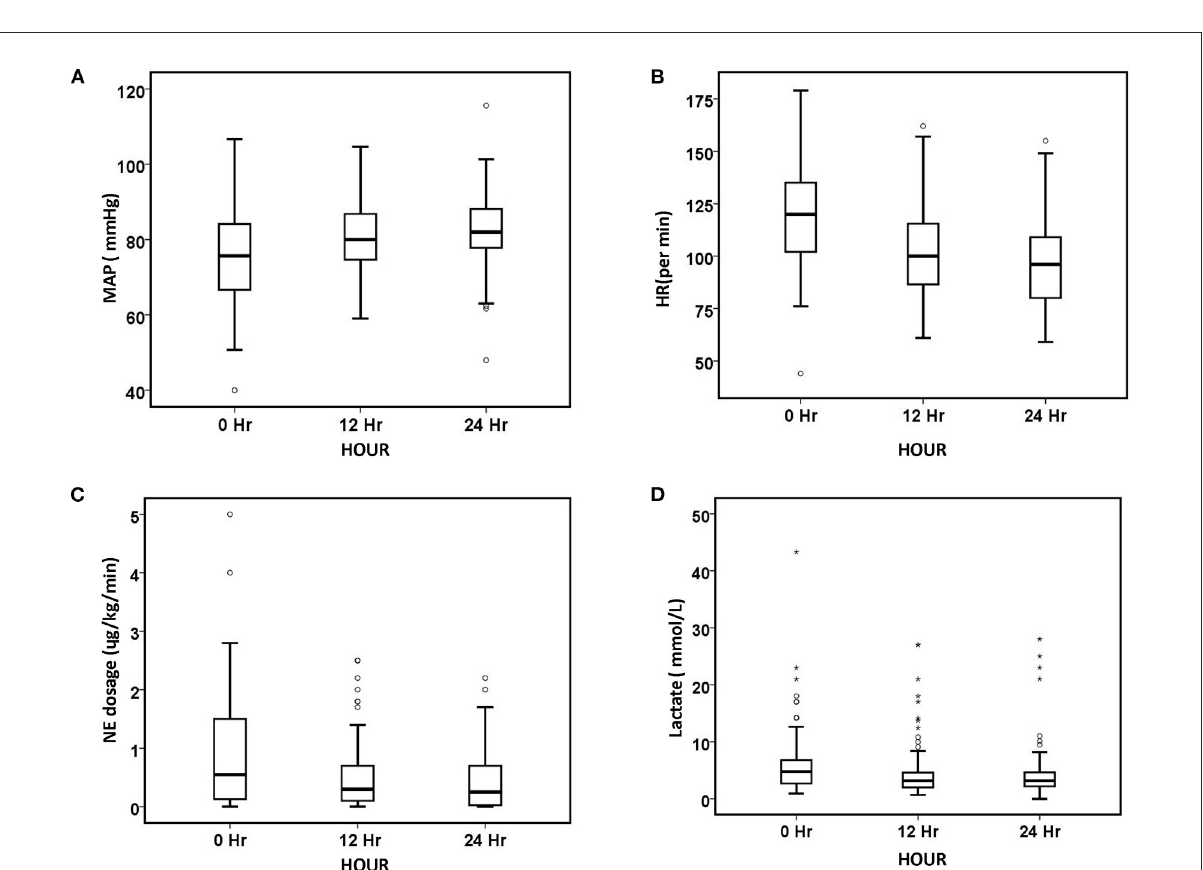
FIGURE1 Changes in hemodynamic parameters and lactate level over 24h. (A) MAP, (B) HR, (C) NE dosage, and (D) lactate. The number of patients at baseline, 12h, and 24h was 90, 85, and 75, respectively. The symbol * stands for outlier.